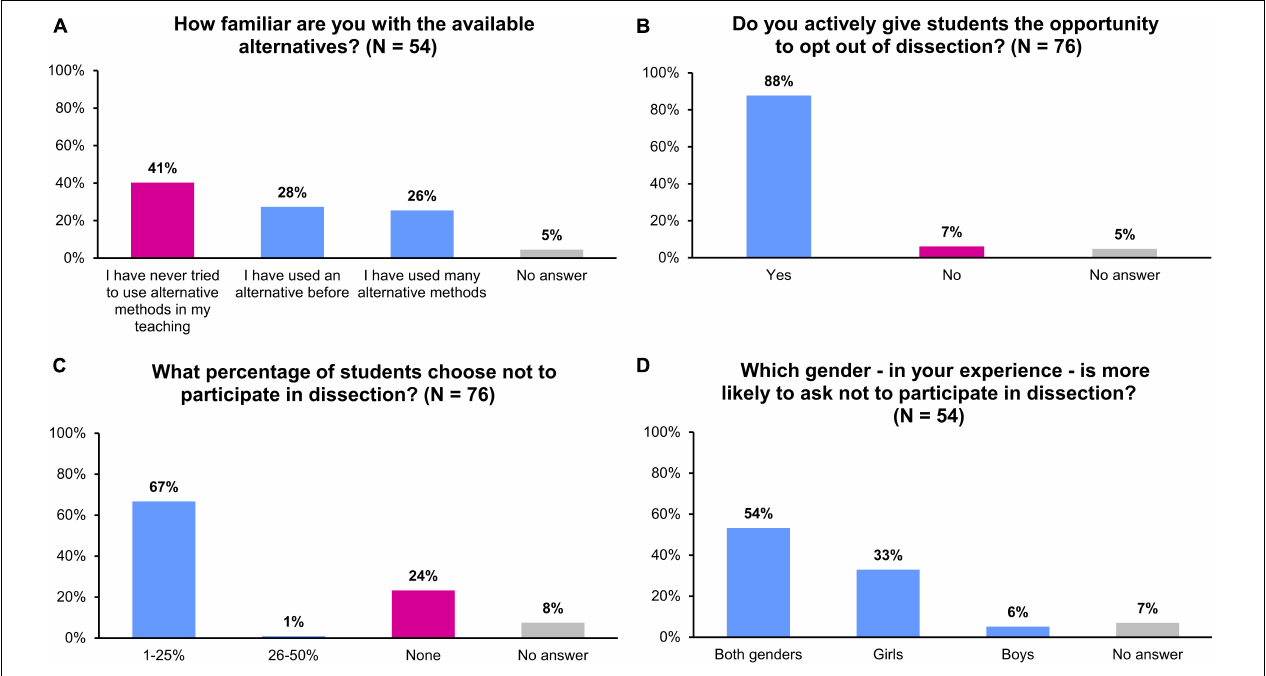
FIGURE 4 | (A) Familiarity of the respondents with the available animal-free alternatives. (B) Proportion of the respondents giving their students actively the opportunity to opt out of dissection. (C) Estimated proportion of students opting out of dissection. (D) Gender distribution among students refusing to participate in dissection.